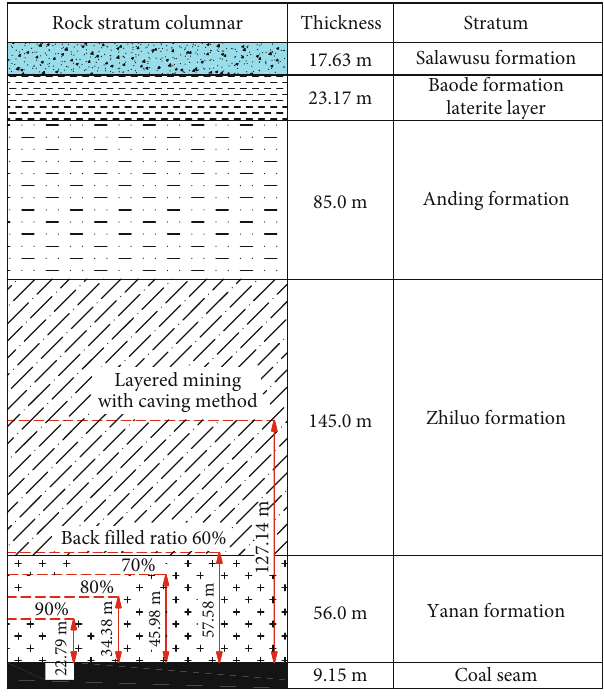
Figure 3: Theoretical calculation results of the height of the water- conducting fractured zone under di ff erent mining